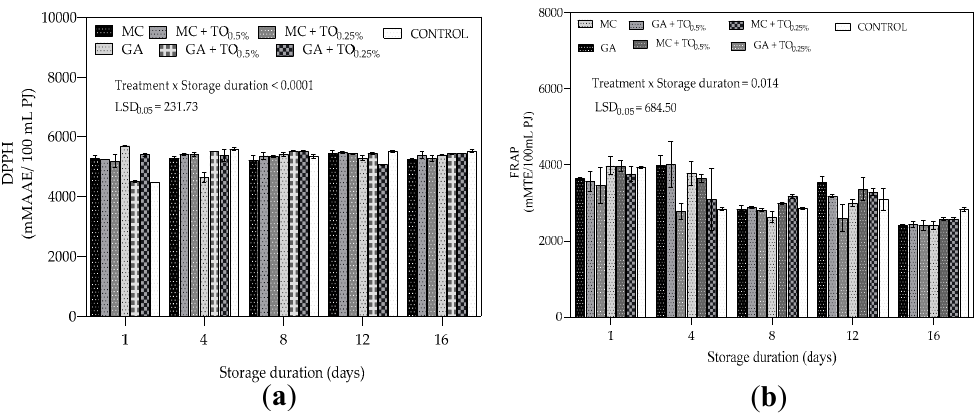
Figure 6. ( a ) DPPH (mMAAE/100 mL PJ) and ( b ) FRAP (mMAAE/100 mL PJ) of “Acco” pomegranate arils coated with gum arabic and methyl cellulose coatings enriched with thyme oil (0.5% and 0.25%) and stored at 5 ± 1 ℃ (95 ± 2% RH) for 16 days. Error bars represent standard error (SE) of the mean values ± S.E. of three replicates. LSD 0.05 represent least significant difference ( p < 0.05).